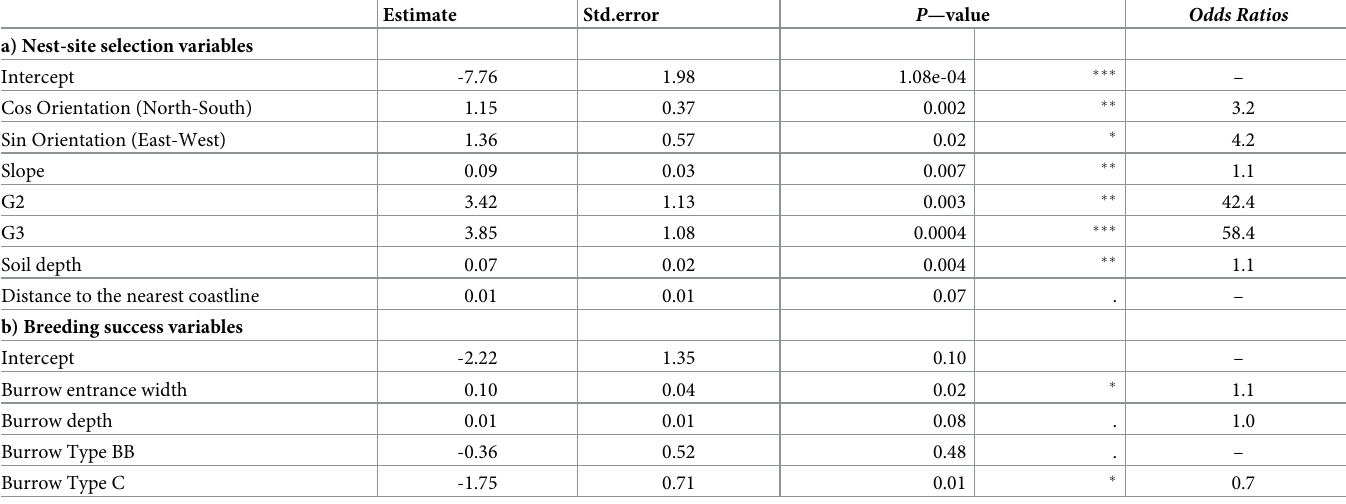
Table 2. Summary tables of logistic regressions explaining the influence of nest-site selection on burrow presence (a) and the factors influencing breeding success (b) of the Tahiti petrel at Nemou